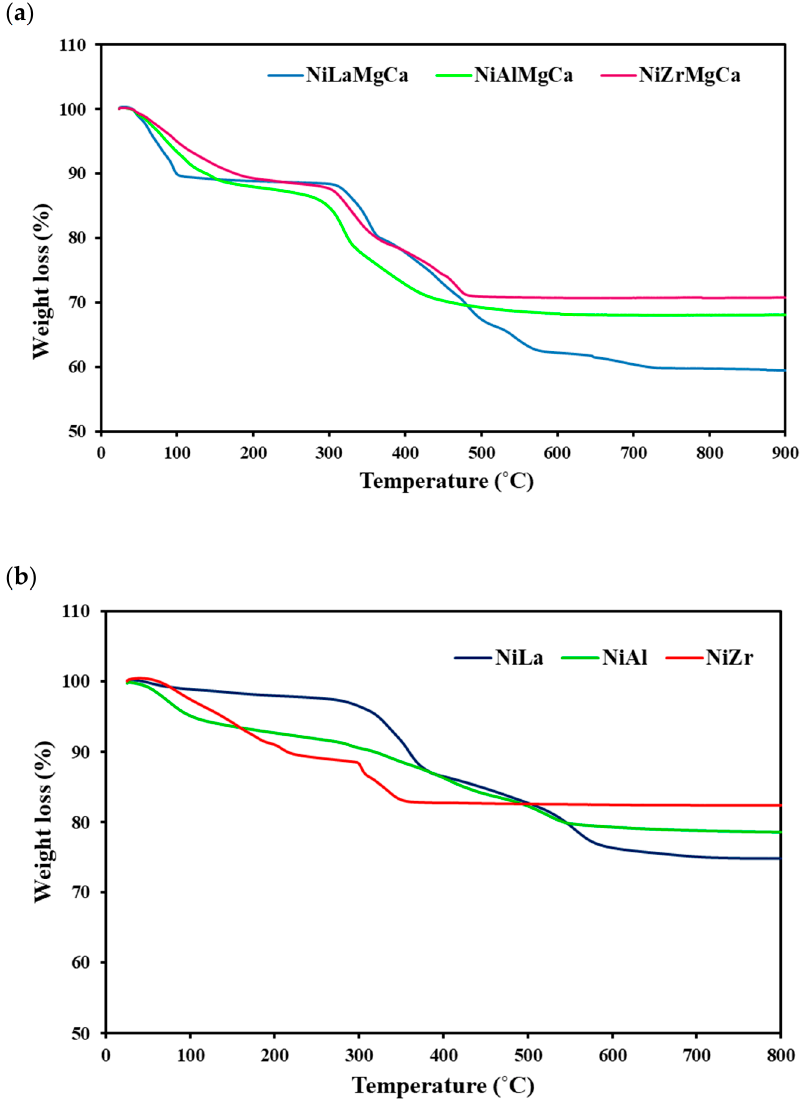
Figure 1. ( a ) TGA graph of fresh Ni‑based catalyst with MgO and CaO promoter; ( b ) TGA graph of fresh Ni‑based catalyst without MgO and CaO promoter. Table 1. Weight loss (%) of fresh catalyst by TGA.